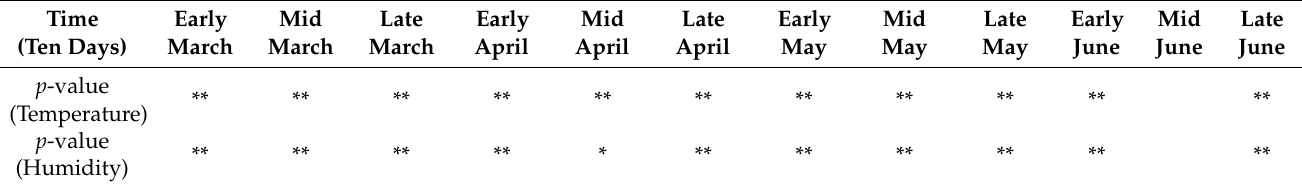
Table 2. The t -test sensitivity analysis of ten-day average temperature and ten-day average relative humidity between healthy and diseased samples from March to